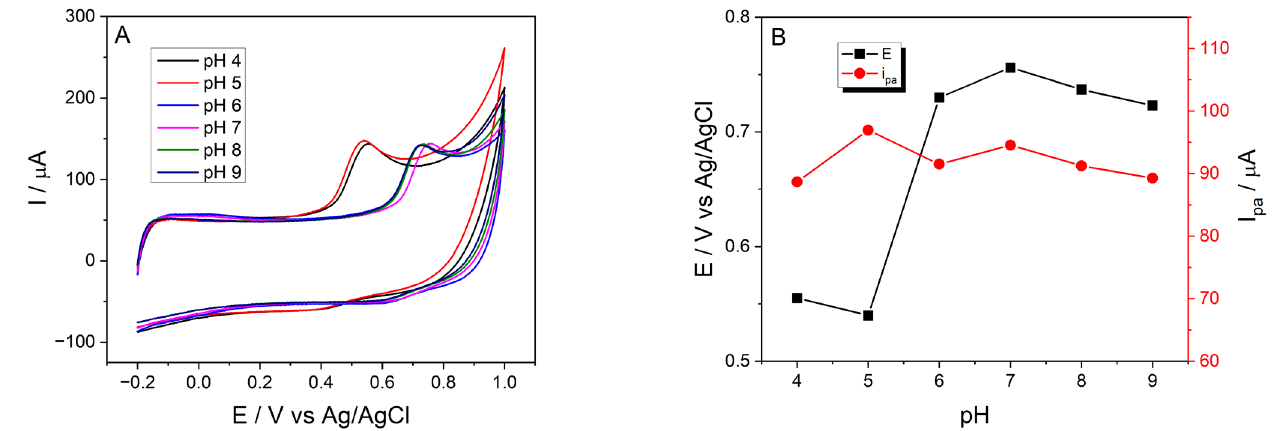
Figure 7. The effect of pH on the electrocatalytic behavior of MWCNT -CS/SPE: ( A ) cyclic voltam- mograms in acetate and PBS buffers containing 1 mM of nitrite , and ( B ) v ariation of oxidation peak potential and current vs. pH.